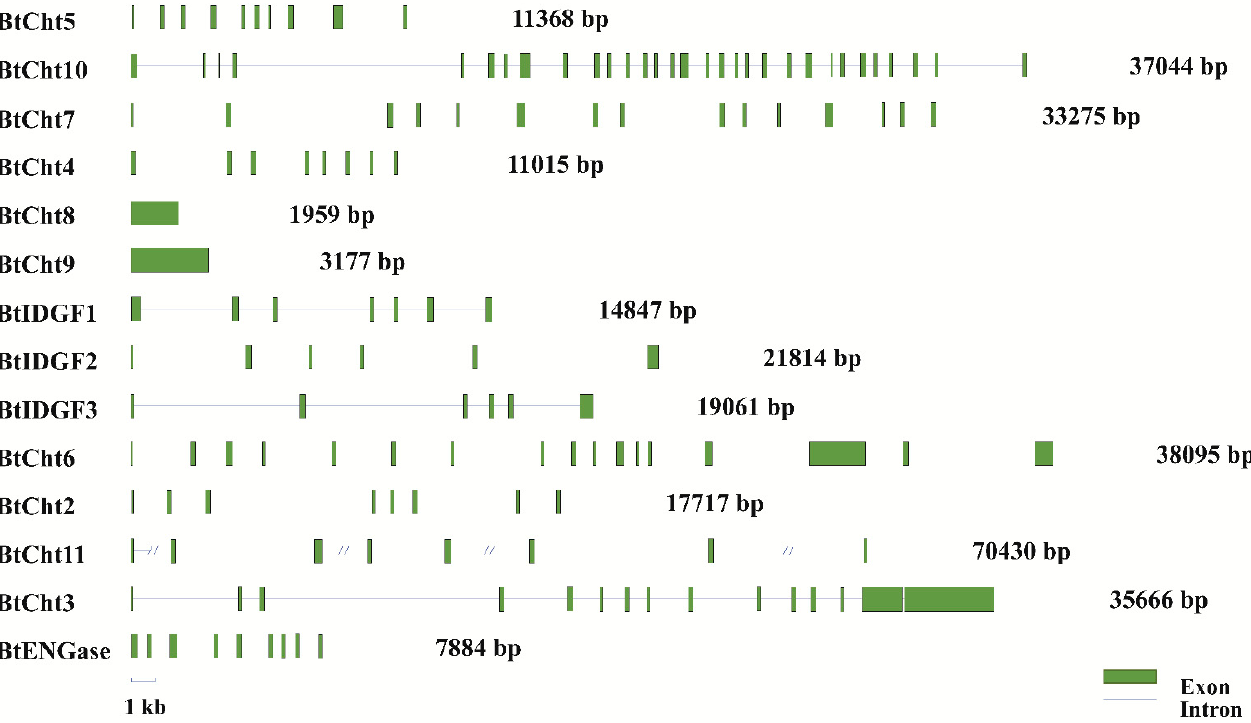
Figure 4. Exon − intron distributions of 14 B. tabaci chitinase-like genes. Genomic sequences and putative cDNA sequences were compared to determine the exon-intron distribution of each chitinase-like genes. Exons are represented by boxes in green and lines separating these green boxes are on behalf of the introns. Cht, chitinase; ENGase, endo- β -N-acetylglucosaminidase; IDGF, imaginal disk growth factor.